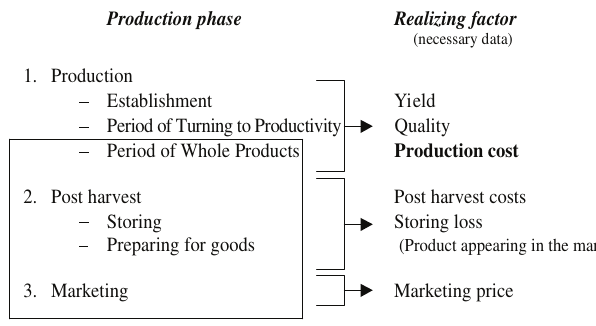
Production phase Realizing factor